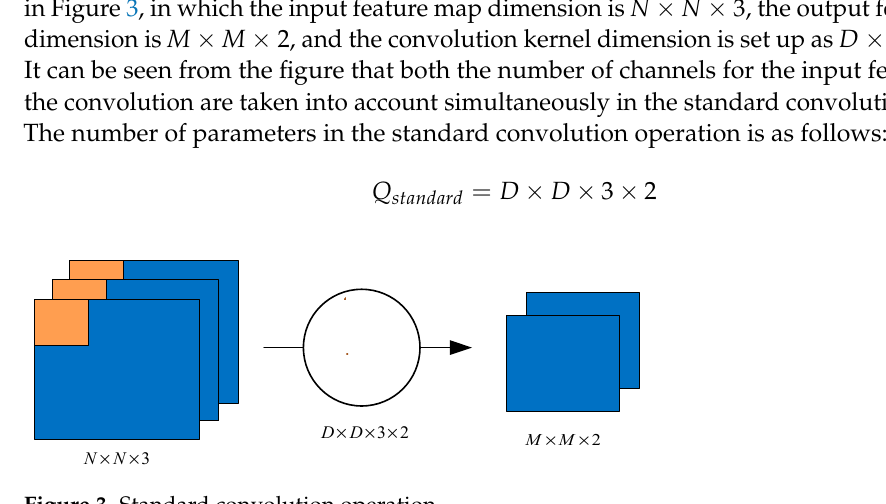
Figure 3. Standard convolution operation.